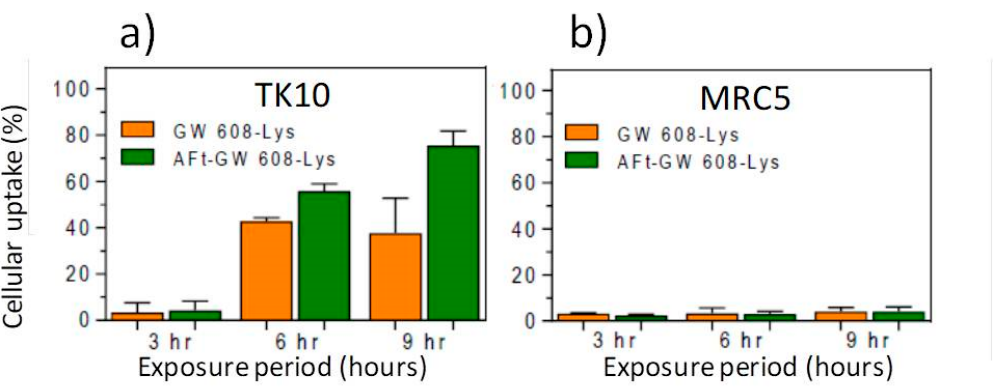
Figure 9. Cellular uptake of GW 608-Lys and AFt-GW 608-Lys by benzothiazole-sensitive TK10 carcinoma cells ( a ) and -insensitive MRC-5 fibroblasts ( b ). Data points are the mean ± SD of 3 independent trials ( n = 3 per trial).